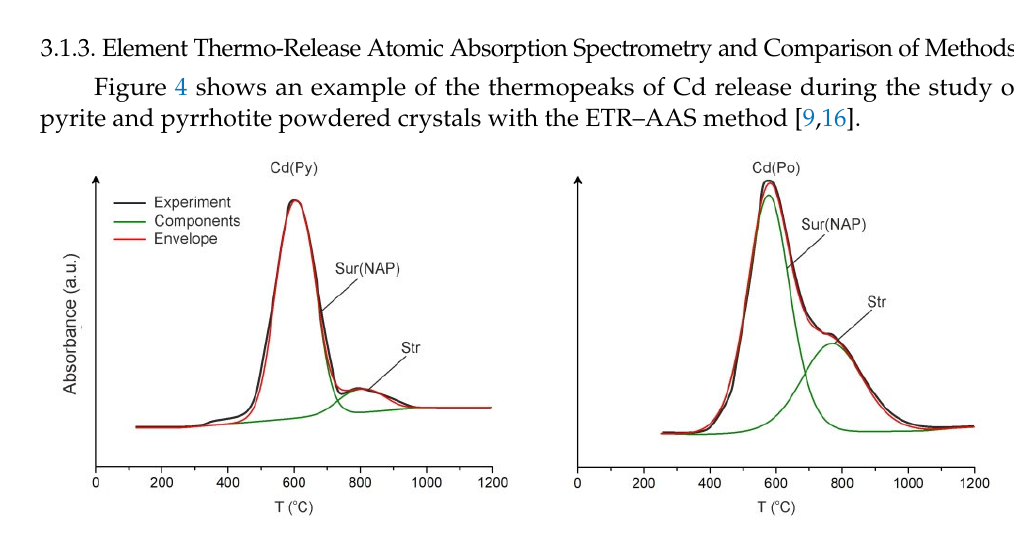
Figure 4. Absorbance–temperature curves of Cd release from pyrite (Py) and pyrrhotite (Po) samples. The NAP-related surficial mode with a maximum release temperature T m of ~600 ◦ C dominates over ples. The NAP ‐ related surficial mode with a maximum release temperature T m of ~600 °C dominates the structural mode with T m ~800 ◦ C. over the structural mode with T m ~800 °C.